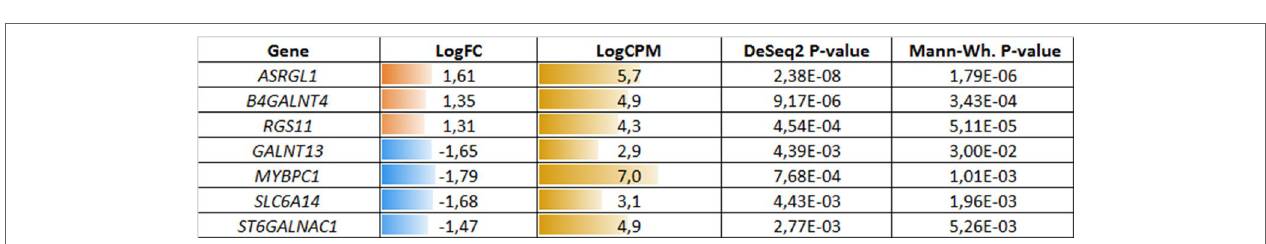
FIGURE 3 | Potential markers of unfavorable prognosis in lymph node-negative locally advanced prostate cancer (LAPC) involved in the enriched KEGG pathways (TCGA data). LogFC—trimmed binary logarithm of average expression level fold change (between the groups of favorable and unfavorable prognosis); LogCPM— binary logarithm of read counts per million